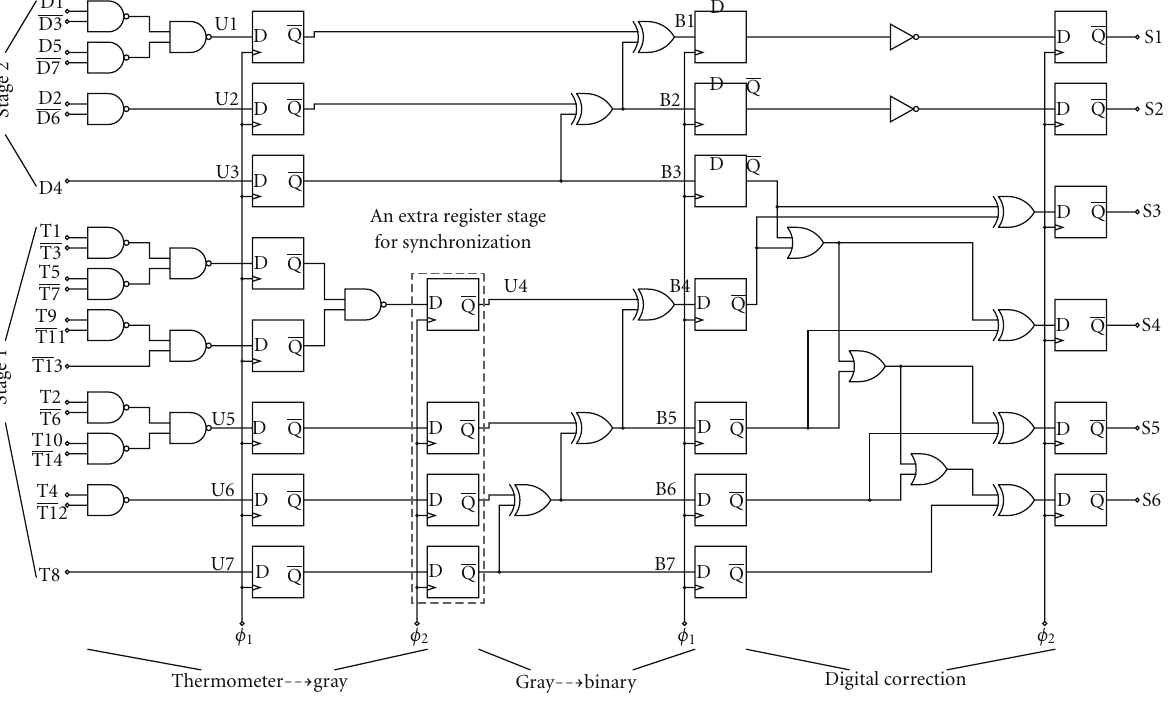
Figure 11: Combination and digital correction.